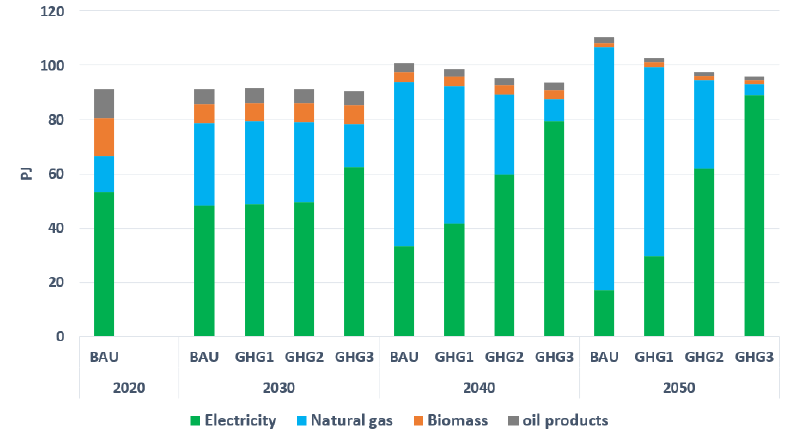
Figure 8. Final energy consumption by type in the residential